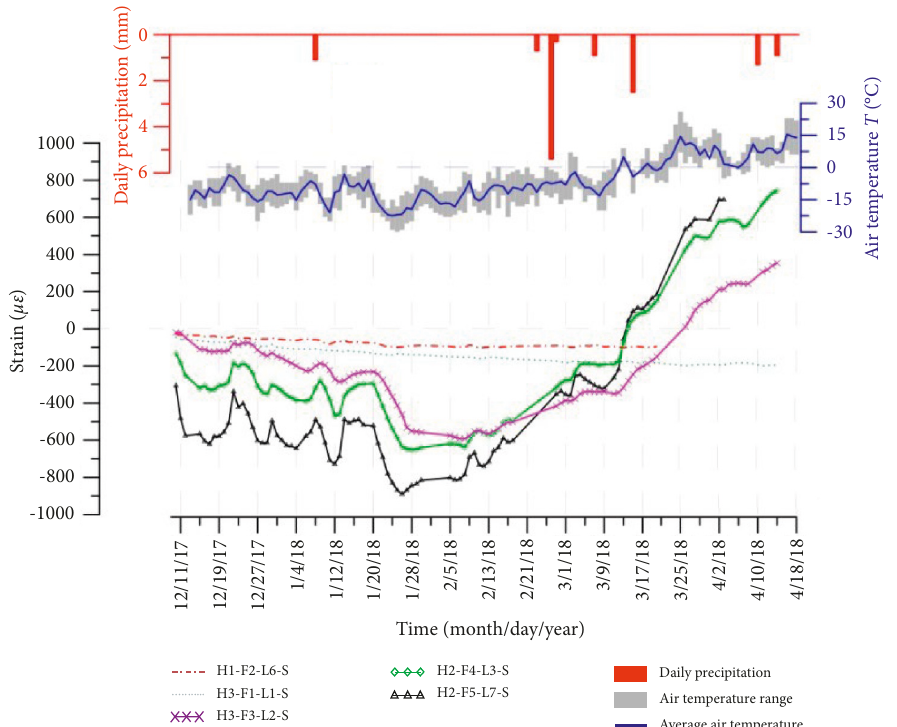
Figure 11: Curves of soil deformation of five layers in the roadbed under climatic